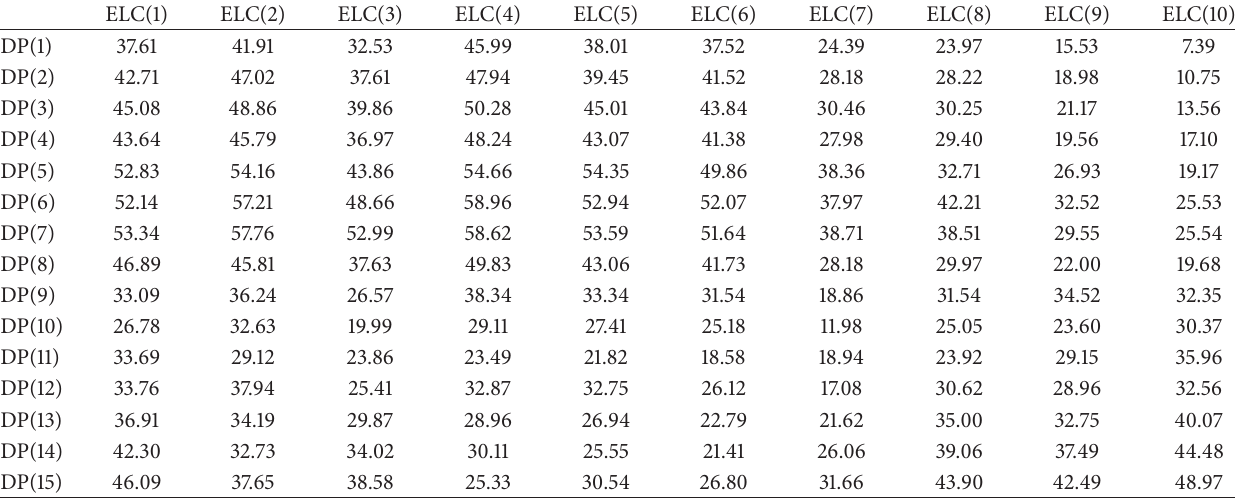
Table 4: The distance between emergency logistics center and demand